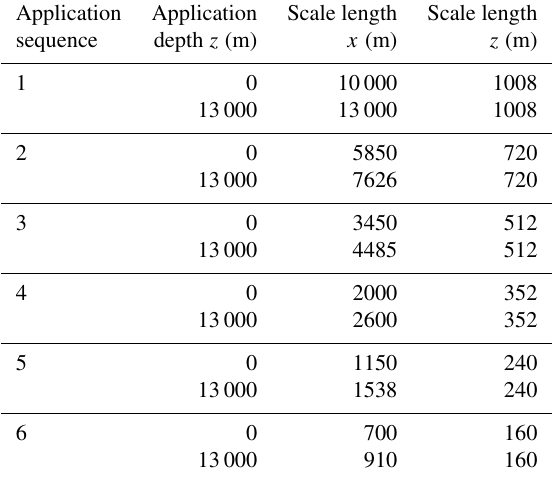
Table 3. Successive smoothing scale length reduction applied for each iteration of the depth